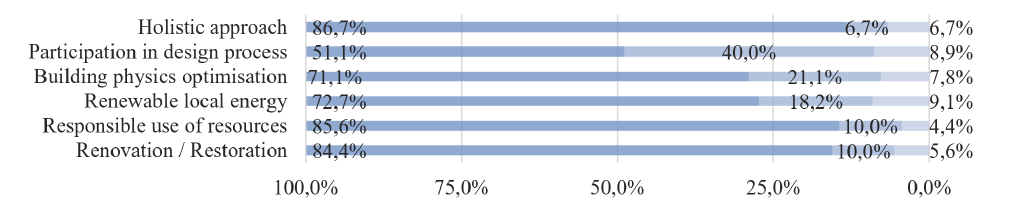
Figure 1. Definition of sustainability (grouped by rated values 1 to 2, 3 to 4 and 5 to 6, where 1 means not applicable at all and 6 fully